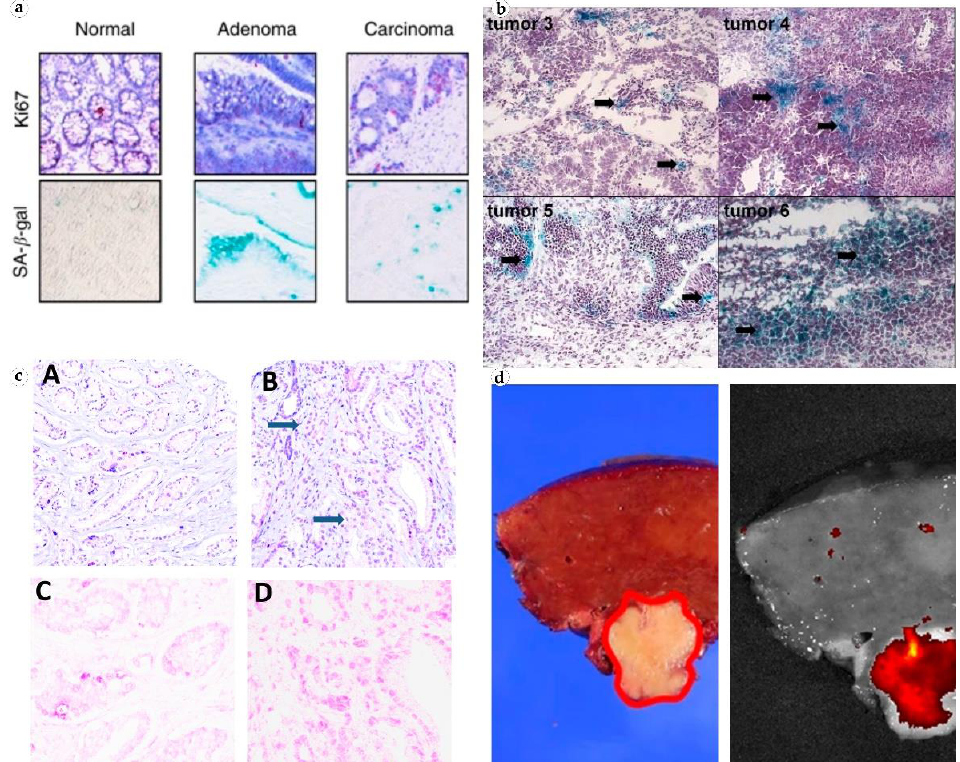
Figure 3. Visualization of SA- β -gal in patient tissues. ( a ) Non-senescent normal colonic crypt mu- cosa, senescent colon adenoma, and a formally non-senescent colon carcinoma with numerous se- nescent cells. Reproduced from [27] under the terms of the Creative Commons CC BY license; ( b ) senescent cancer cells in ovarian tumors from patients who did not receive chemotherapy. Repro- duced from [24] under the terms of the Creative Commons CC BY-NC-SA license; ( c ) prostate can- cer tissue, H&E ( top ), and antibodies to GLB1 ( bottom ). Reproduced from [33] under the terms of the Creative Commons CC BY license; ( d ) fluorescence imaging of β -galactosidase in freshly re- sected human hepatocellular carcinoma. Reproduced from [36] under the terms of the Creative Commons CC BY